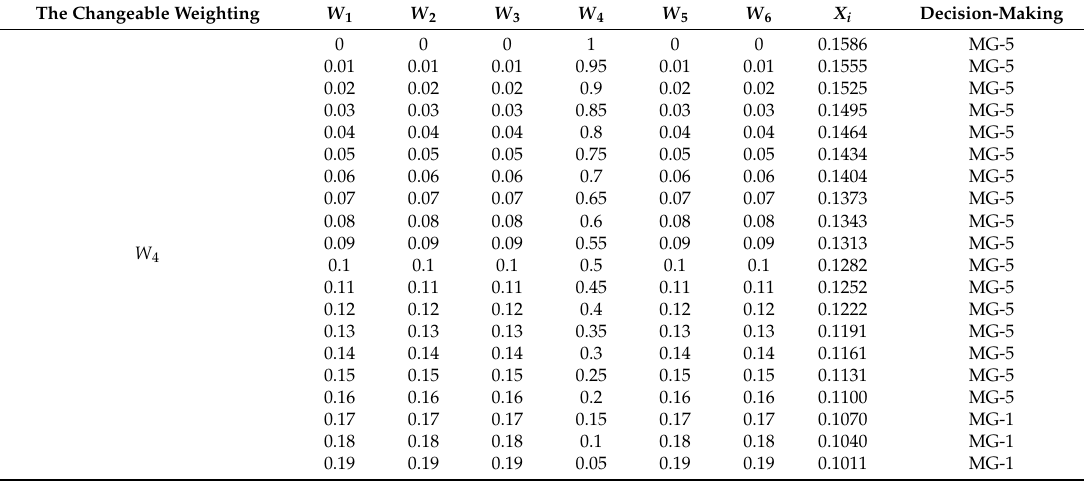
Table A4. Biased weighted index of power loss in transmission line index for the modified transmission lines between MG-2 and